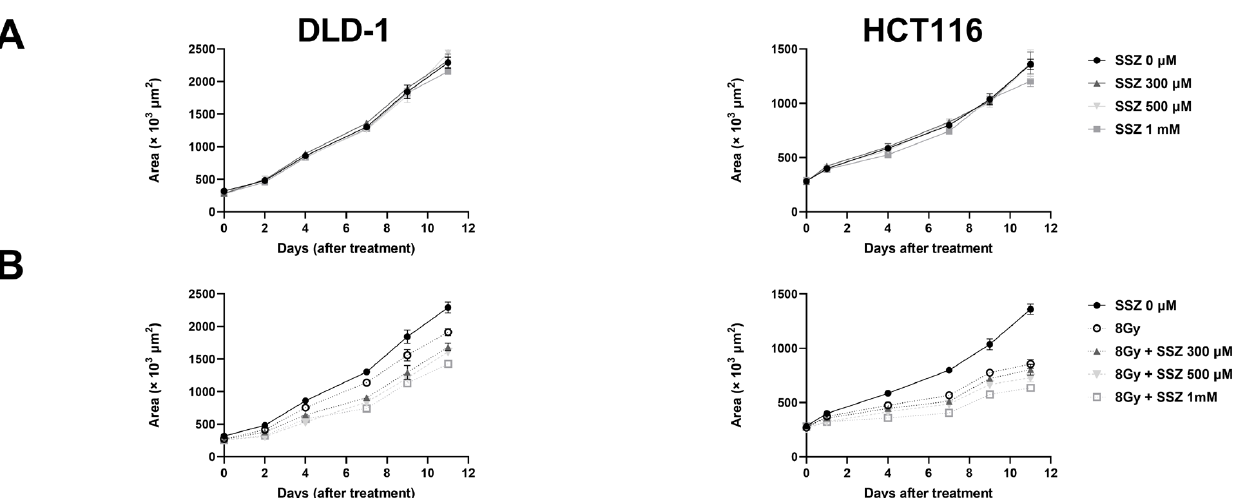
Figure 6. SSZ radiosensitizes colorectal cancer spheroids in a similar manner observed in 2D cul- tures. DLD- 1 and HCT116 3D models were treated with SSZ (16 h) and irradiated with 8 Gy. ( A ) The growth of the spheroids was followed up by the EVOS after SSZ treatment (16 h) in DLD- 1 (left) and HCT116 (right) 3D models under hypoxic conditions (0.1%). ( B ) Spheroid growth was followed up after SSZ treatment (16 h) and irradiation with 8 Gy in DLD- 1 (left) and in HCT116 (right). ( C ) Representative pictures of the levels of ROS under hypoxic conditions (1%) in DLD- 1 (top) and in HCT116 (bottom). ( D ) Summarizing graphs showing the mean gray values in DLD- 1 (left) and HCT116 (right). ( E ) Representative pictures of the amount of lipid peroxidation after SSZ treatment under hypoxic conditions (1%) in DLD- 1 (top) and in HCT116 (bottom). ( F ) Summarizing graphs showing the mean gray values in DLD- 1 (left) and HCT116 (right). Data represented as mean ± SEM,